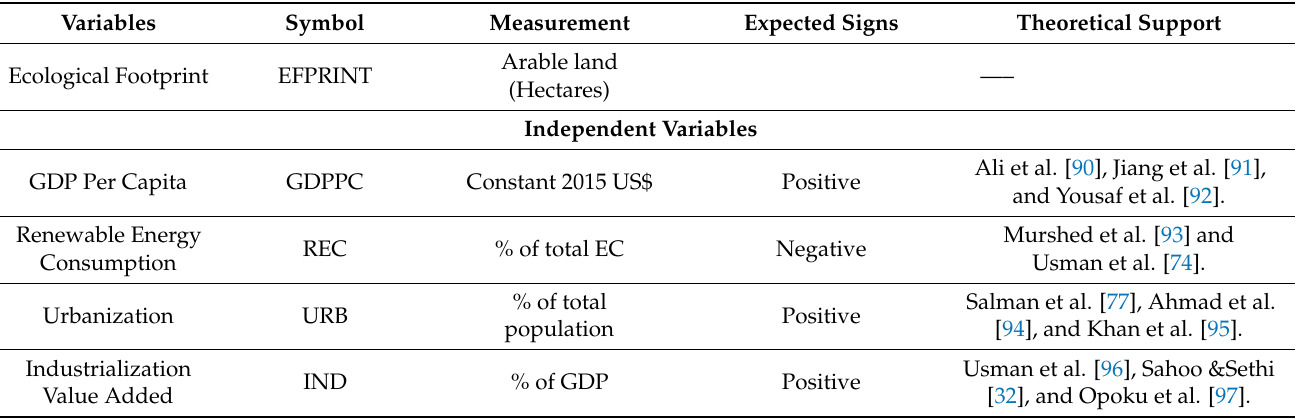
Table 2. List of